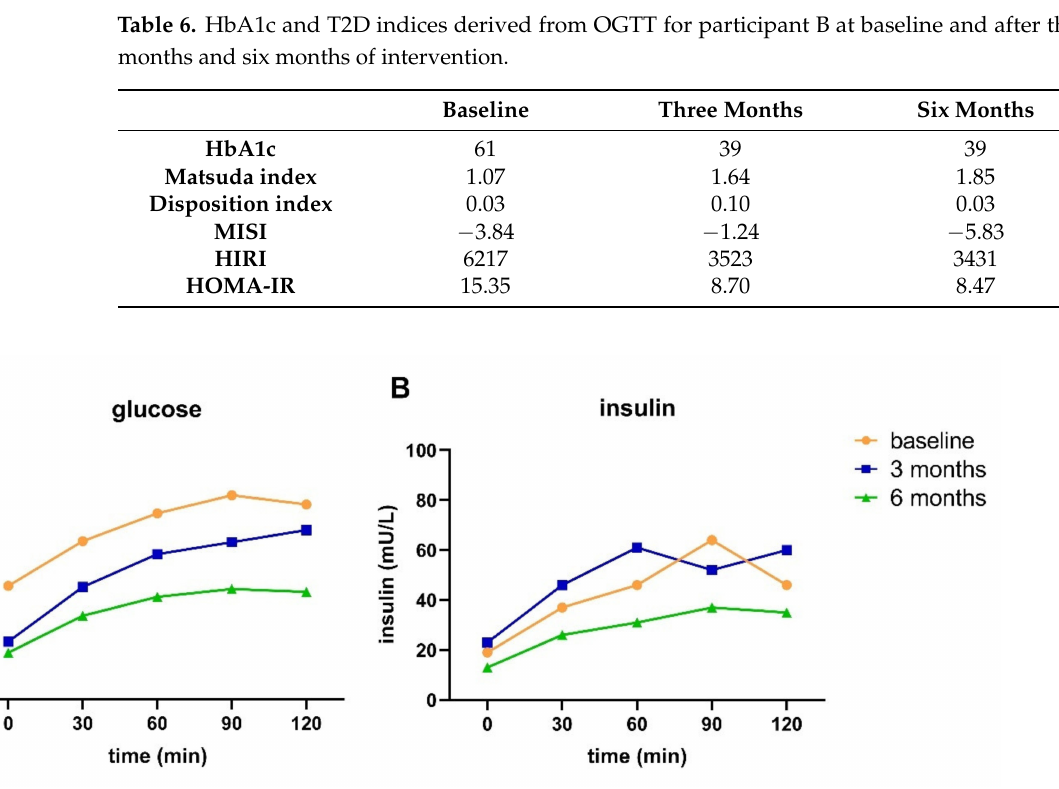
Figure 4. Glucose ( A ) and insulin ( B ) response to an OGTT at baseline and after three and six months of intervention for participant